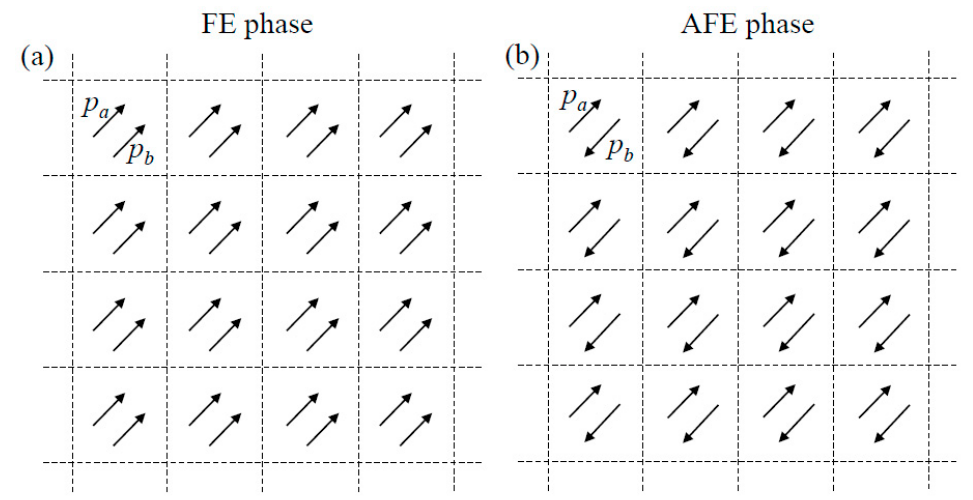
Figure 1. Schematic of the ( a ) ferroelectric (FE) and ( b ) antiferroelectric (AFE) phases.